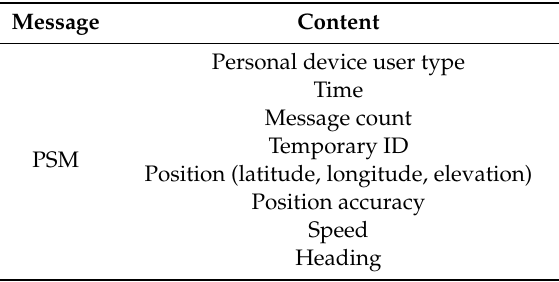
Table 6. Personal safety message (PSM)